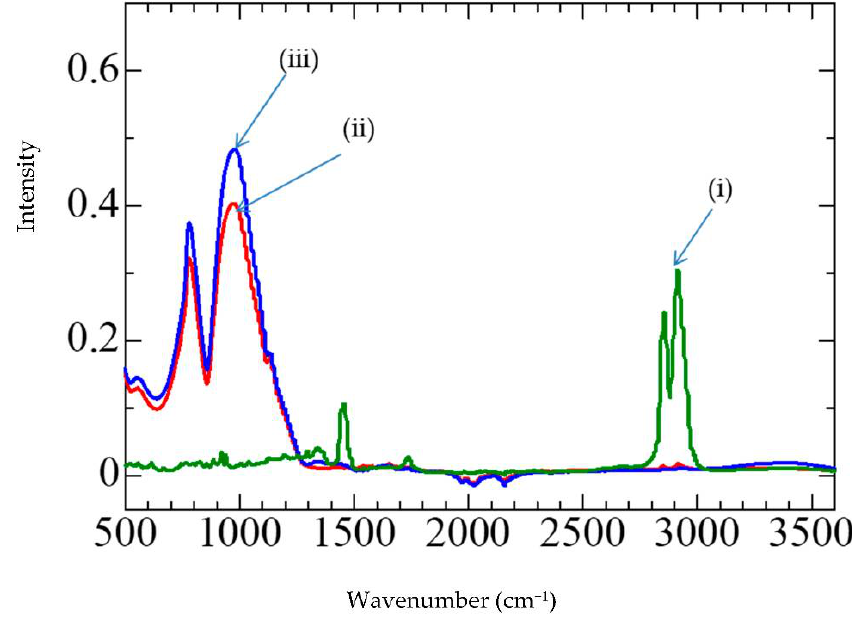
Figure 7. FTIR spectra of the (i) the BOPET film, (ii) the dried methanol on glass substrate, and (iii) the quartz glass specimen that was stamped with a BOPET film mold.